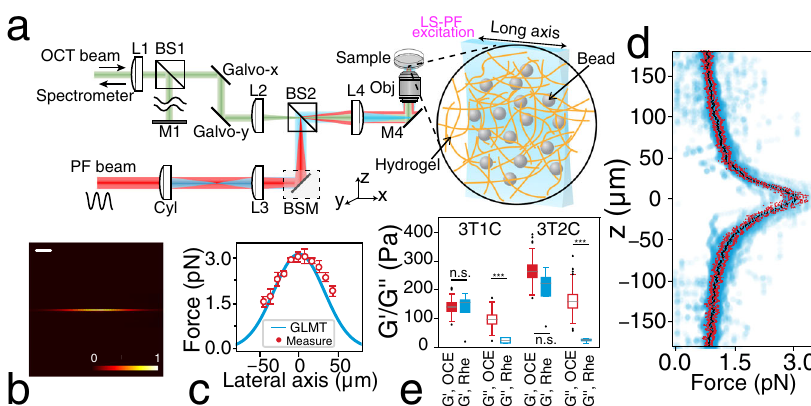
Fig. 1 LS-pfOCE system characterisation and validation. a Schematic of the LS-pfOCE system. Light-sheet radiation-pressure excitation is generated by a cylindrical lens and combined in free-space with the sample arm of a spectral-domain OCT system for interferometric detection of radiation-pressure- induced bead oscillations. See “ Methods ” for a full description of the LS-pfOCE system. L: lens, Cyl: cylindrical lens, BS: beam splitter, BSM: beam-steering module, M: mirror, Obj: microscope objective. b Normalised light-sheet intensity pro fi le measured at the focal plane. Scale bar = 20 µ m. c Measured (red, mean ± standard deviation from N = 48 beads) and simulated (blue, Generalized Lorenz-Mie Theory (GLMT), see Supplementary Method 6) lateral light- sheet radiation-pressure pro fi le at its focal plane on 1.9- µ m melamine-resin beads. d Measured axial light-sheet radiation-pressure pro fi le at its lateral centre on 1.9- µ m melamine-resin beads, showing data (blue) and depth-dependent median (black) and median absolute difference (red) from N = 48 beads. See “ Methods ” for light-sheet radiation-pressure force measurement procedure. e Comparison of G ′ and G ″ in PAAm gels measured by 3D LS- pfOCE (red, OCE) and bulk shear rheometry (blue, Rhe) at 20 Hz. Each box represents data from N = 5 samples for rheometry and N = 225 and 263 beads for LS-pfOCE in 3T1C and 3T2C gels, respectively. Horizontal line indicates median, box spans 1st to 3rd quartile, and whisker length corresponds to 1.5 times the interquartile range. Signi fi cant difference in group means (two-sided Welch ’ s t-test) is indicated by *** p value < 0.001 and n.s. p value >